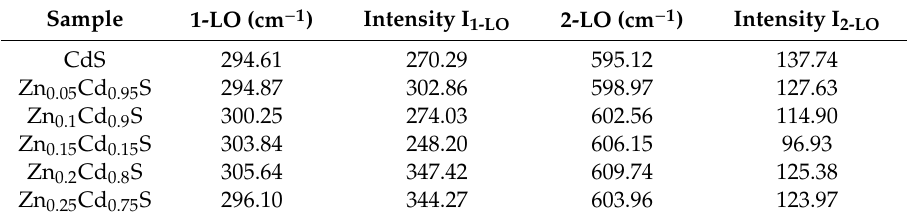
Table 2. Peak position and intensity of undoped and Zn-doped CdS